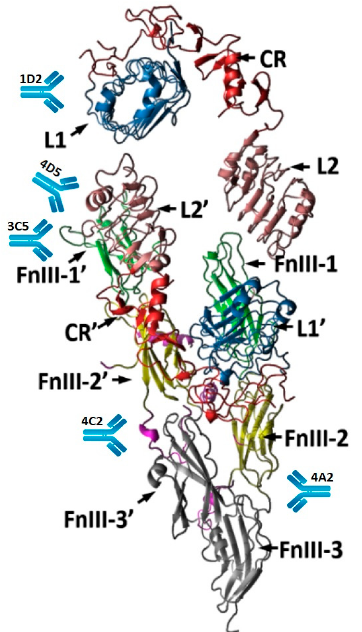
Figure 1. Scheme of the binding of monoclonal antibodies to IRR. Structure was taken from [18].